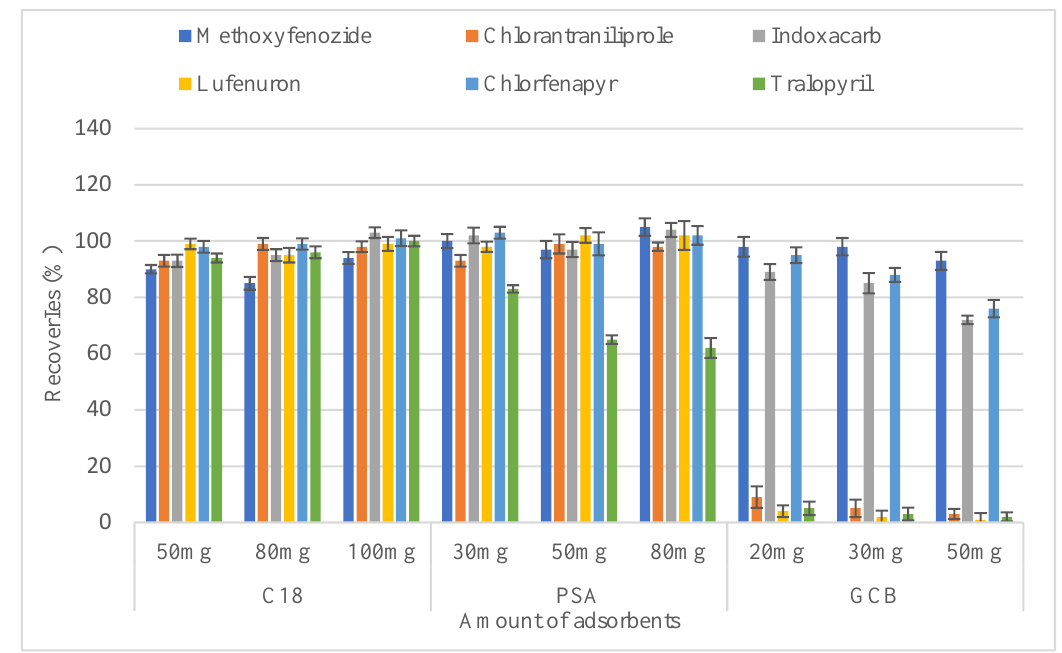
Figure 1. The recoveries of the six compounds in acetonitrile by different adsorbents.